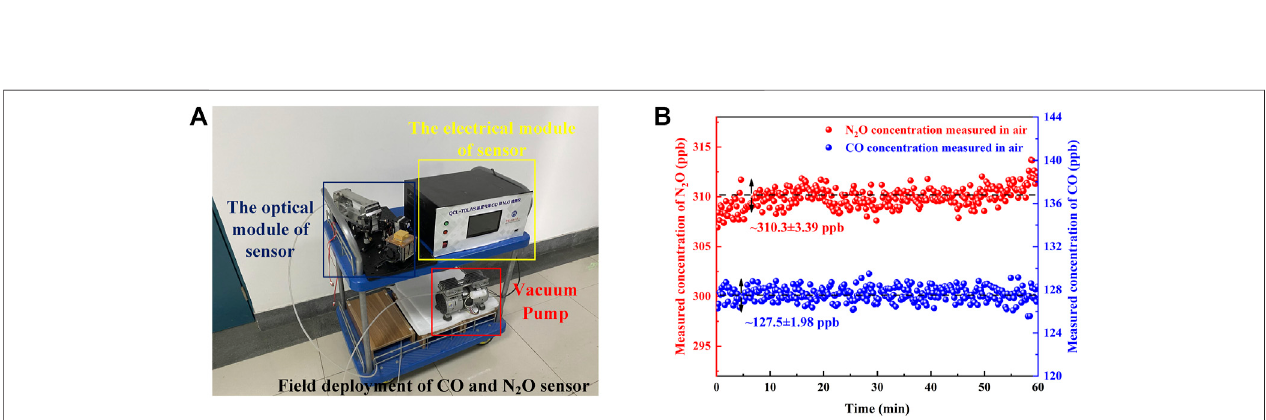
FIGURE 9 | (A) Photograph of the sensor for the fi eld deployment. (B) The real-time measured concentrations of the sensor.